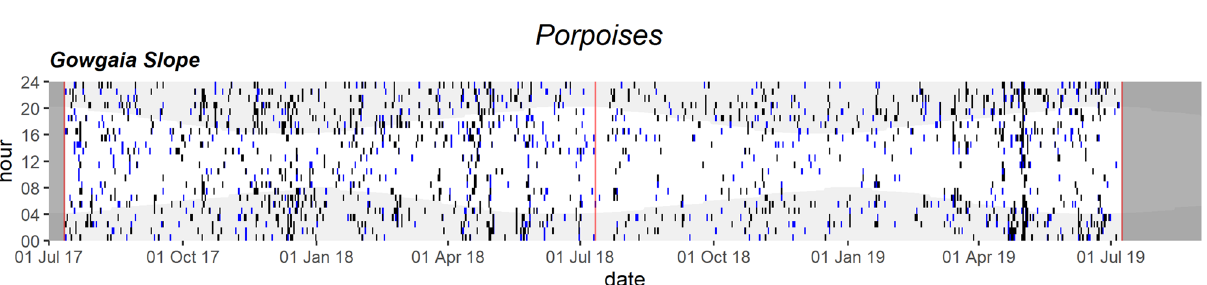
Figure 10. Daily and hourly occurrence of porpoise vocalizations at Gowgaia Slope in 1-h bins. Blue dots indicate automated detections. Black dots indicate confirmed occurrence. Red lines indicate recorder deployment and retrieval dates. Dark grey areas indicate a lack of recordings. Light grey shaded areas indicate hours of darkness.